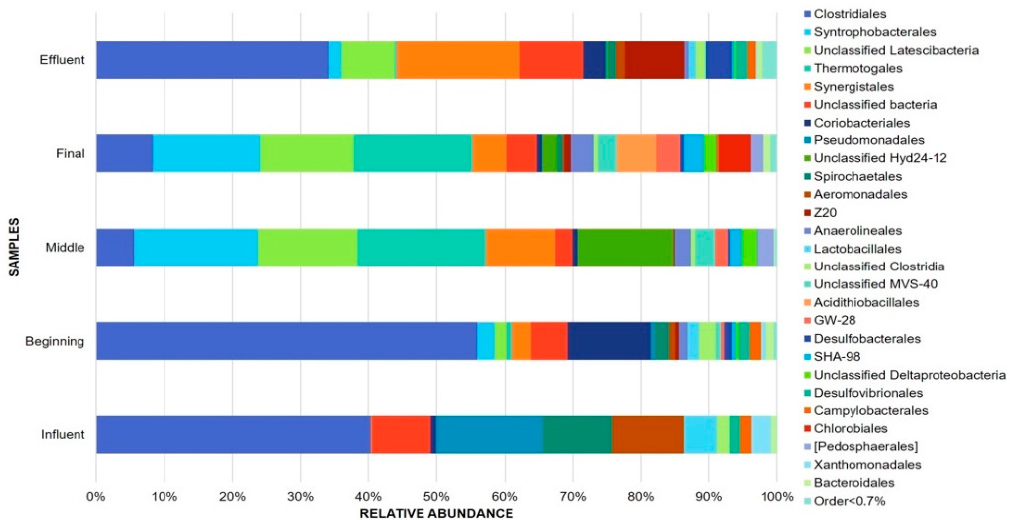
Figure 3. Relative abundance at order level among the different sampling sites of the